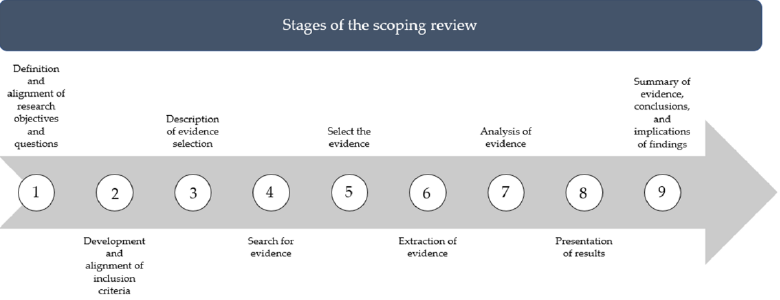
Figure 1. Stages of the scoping review.